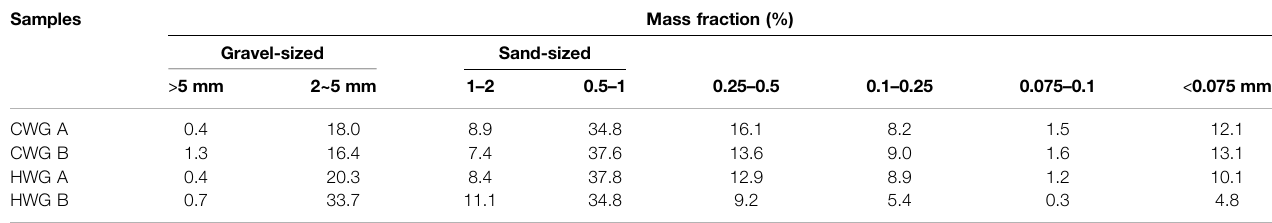
TABLE 2 | The mass fractions of weathered granites in the Lincang area.